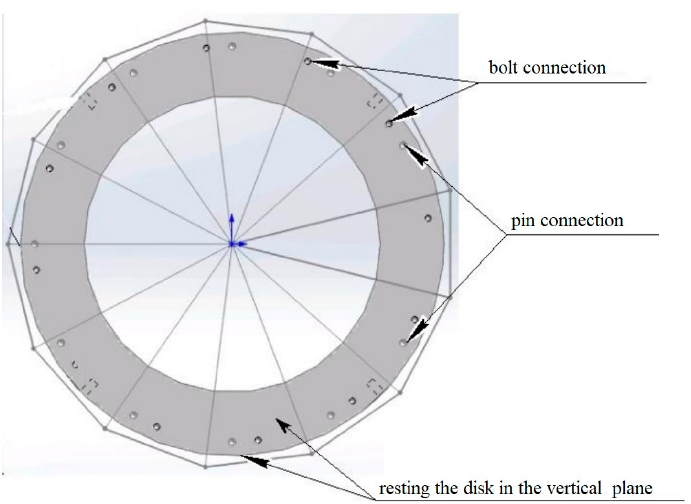
Figure 3. Calculation model of the thrust bearing disc.